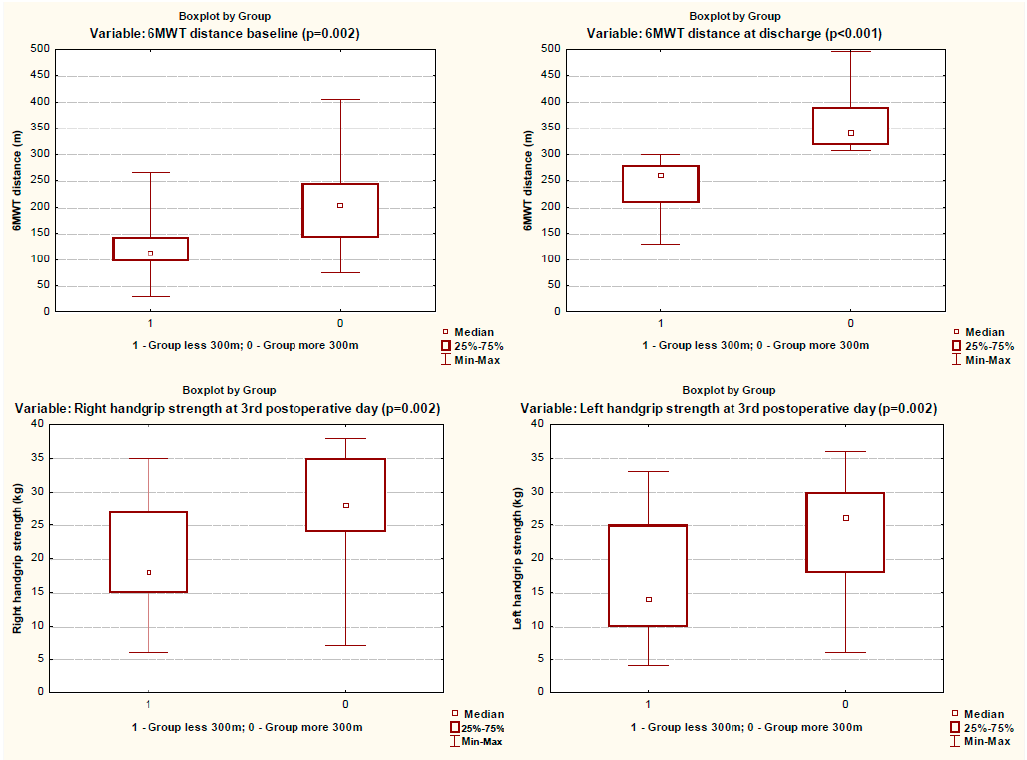
Figure 4. The 6MWT distance at baseline and at discharge and handgrip strength on 3rd postoperative day in groups. When the test was repeated, the muscle strength increased significantly, while at the time of discharge, the differences in the strength of the muscle groups remained (Table 3). The frequency of NMES during inpatient rehabilitation did not differ between the groups either. Table 3. Muscle status at discharge in groups. Group 1 ( n = 31)